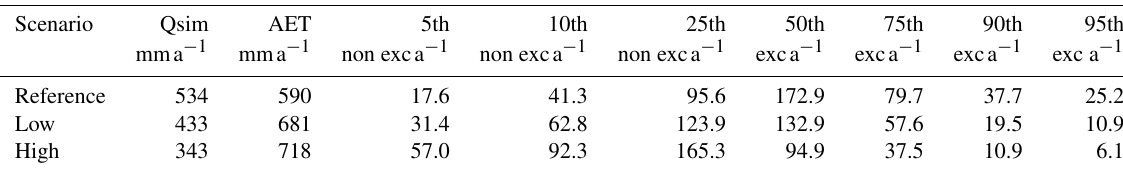
Figure 7. Mean model input (mma − 1 ), mean modelled output (mma − 1 ) and mean (non-)exceeded percentiles (numbera − 1 ) in the reference period and both scenarios (borehole: Ashton Farm; future period: 2070–2099). The circles indicate the spread among the nine realisations for each of the two scenarios. Table 4. Model output and (non-)exceedances of percentiles in the reference period and the two scenarios (borehole: Ashton Farm, time period